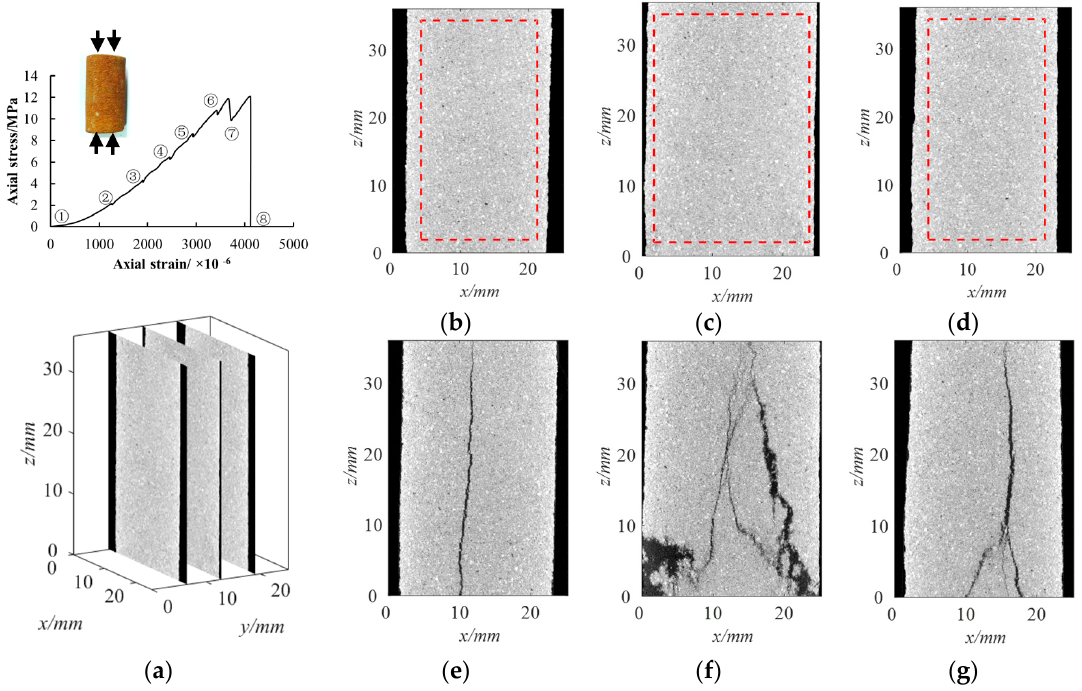
Figure 3. Stress–strain curve and reconstructed sectional images along y = 6.20 mm, 12.5 mm and 18.80 mm: ( a ) Stress–strain curve and three orthogonal sectional images of step 6; ( b – d ) sectional images of step 6, respectively; ( e – g ) sectional images of step 8, respectively.